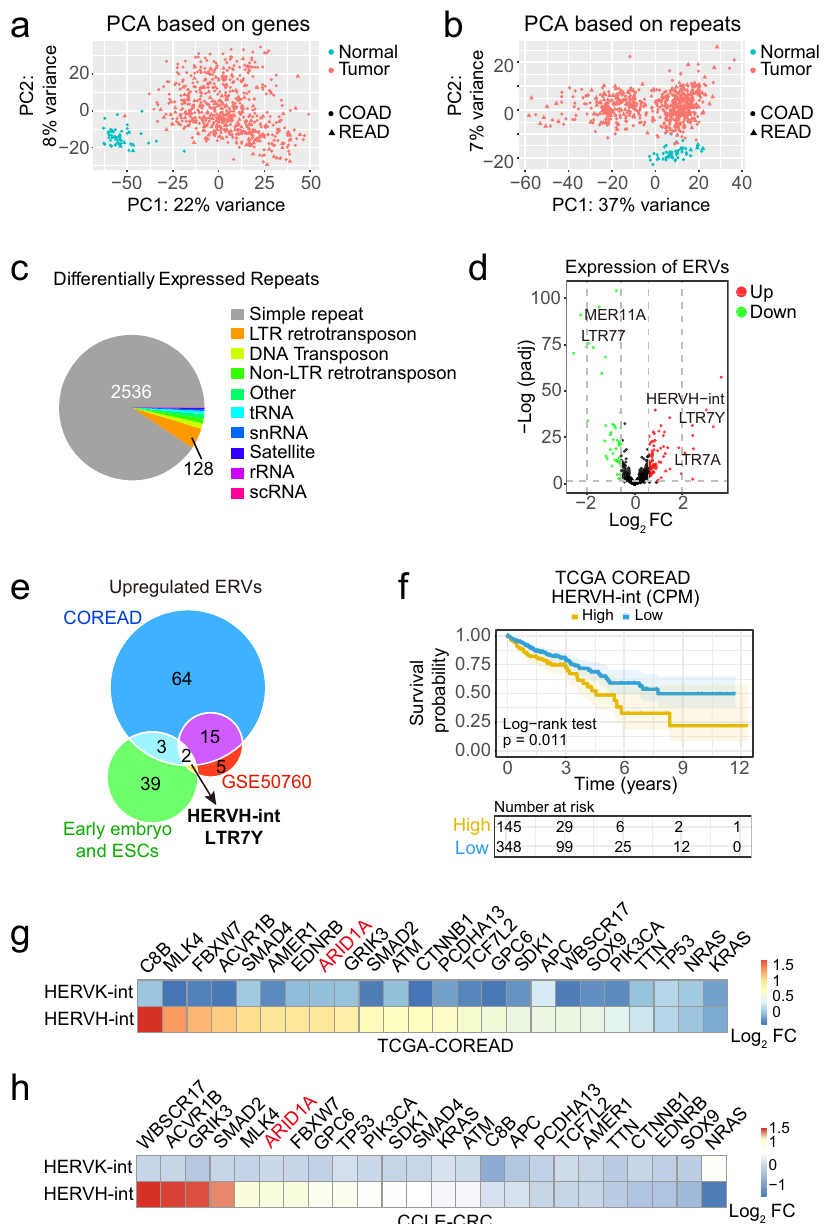
Fig. 1 Characterization of HERVH expression in CRCs. a PCA of gene expression of 51 normal and 631 CRC tumor tissues from the TCGA COREAD dataset. b PCA based on the expression of repetitive sequences. c Classi fi cation of differentially expressed repetitive sequences analyzed using DESeq2 (version v1.22.2, with two-tailed likelihood ratio test). Differentially expressed repetitive elements are determined with the cut-off values of adjusted p value <0.05 and |Log 2 FC (Fold Change)| >0.585. d Volcano plot of the differentially expressed ERVs analyzed using DESeq2 (version v1.22.2, with two- tailed likelihood ratio test). Up (red) and down (green) regulated ERVs are determined with the cut-off values of adjusted p value <0.05 and |Log 2 FC | > 0.585. e Overlap analysis of the upregulated ERVs in CRCs samples and early embryonic cells identi fi es the internal coding sequences of HERVH (HERVH-int) and its corresponding LTR (LTR7Y) as the commonly upregulated elements. f Survival analysis based on the expression level of HERVH-int and the overall survival (OS) from 493 patients with AJCC pathologic tumor stage >I. The mean expression value of HERVH-int is used to demarcate the HERVH-int-High (145 patients) and HERVH-int-Low (348 patients) groups. Log-rank test, p = 0.011. g Correlation analysis of HERVH - int expression and mutational status of the most frequently mutated genes in CRCs using the TCGA dataset. h Correlation of HERVH-int expression and gene mutations in CRC cell lines in the CCLE dataset. The data used to generate each panel in Fig. 1 are listed in Supplementary Data 1. Source data including exact p values are provided as a Source data fi